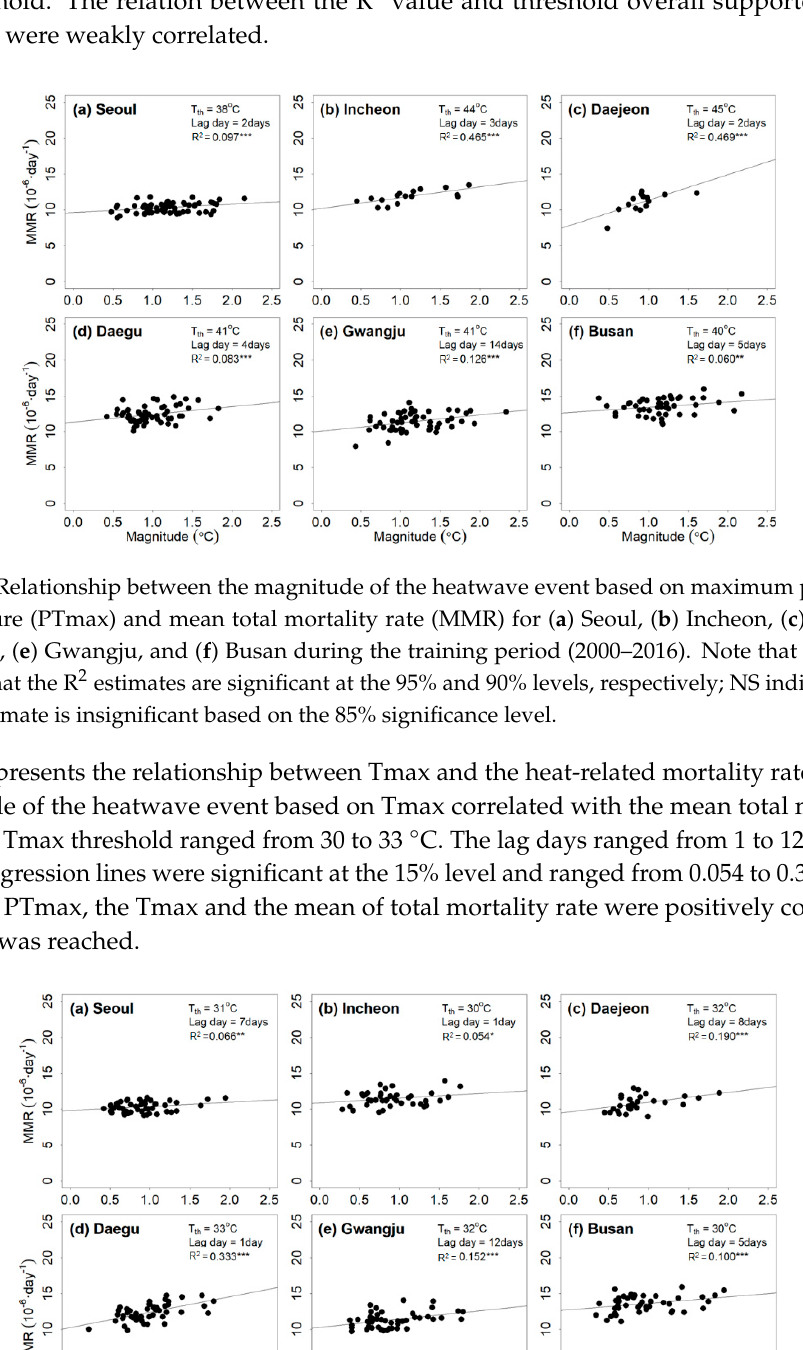
Figure 3. Relationship between the magnitude of the heatwave event based on maximum air temperature (Tmax) and mean total mortality rate (MMR) for (a) Seoul, (b) Incheon, (c) Daejeon, (d) Daegu, (e) Gwangju, and (f) Busan during the training period (2000–2016). Note that ***, **, and * indicate that the R (cid:2870) estimates are significant at the 95%, 90%, and 85% levels, respectively; NS indicates that the R (cid:2870) estimate is insignificant based on the 85% significance level.